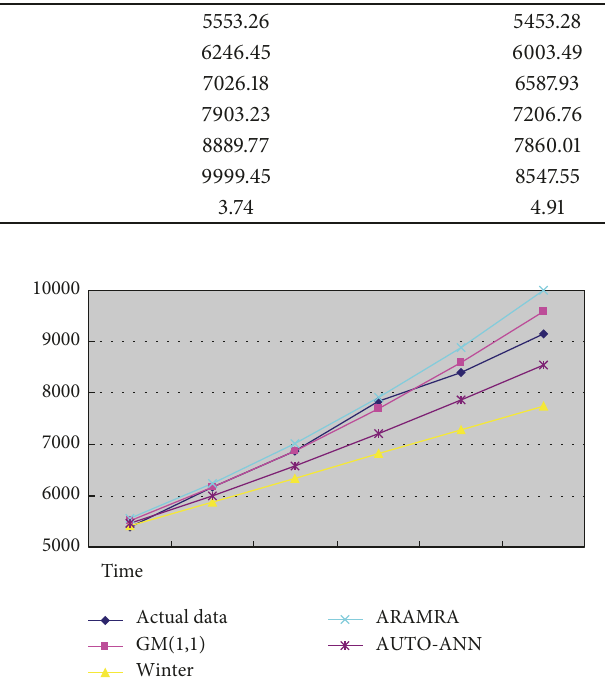
Figure 7: The predicted and true values for M3C